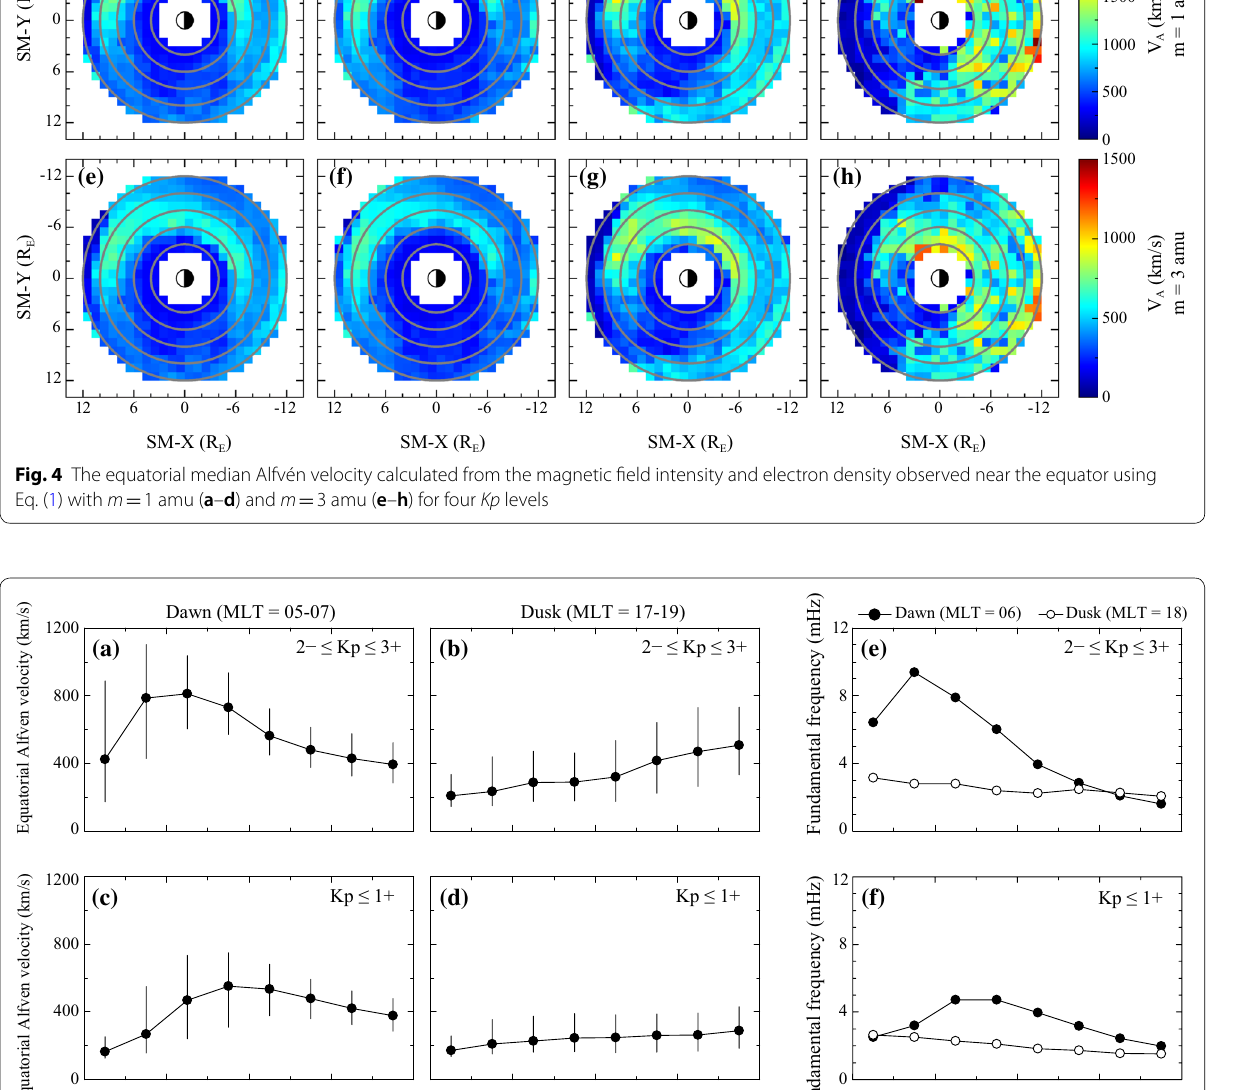
05–07) and duskside (MLT 17–19) with the equatorial mass density = =